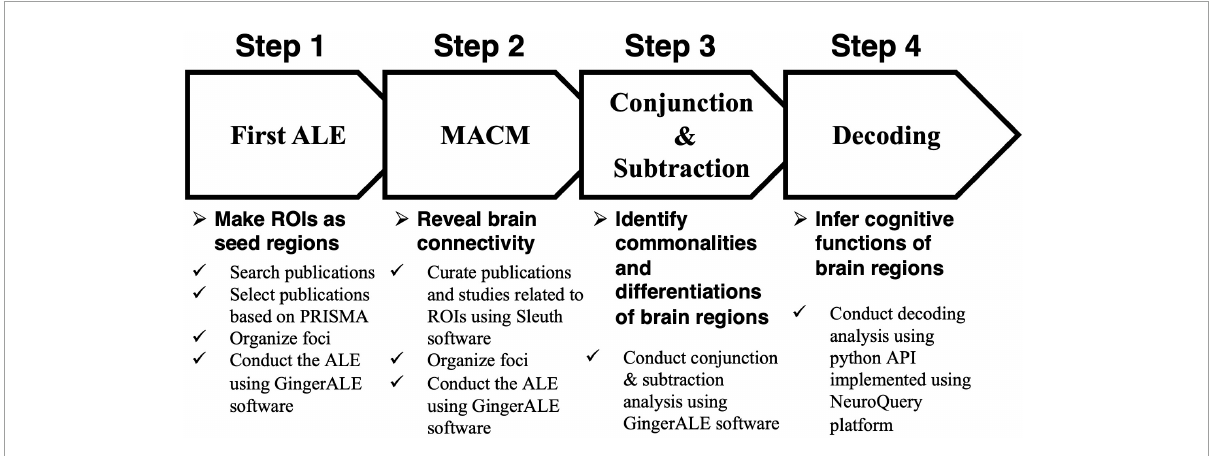
FIGURE3 Steps of the analysis. ALE, activated likelihood estimation; ROI, region of interest; PRISMA, preferred reporting items for systematic reviews and meta-analyses; MACM, meta-analytical connectivity modeling; API, application programming